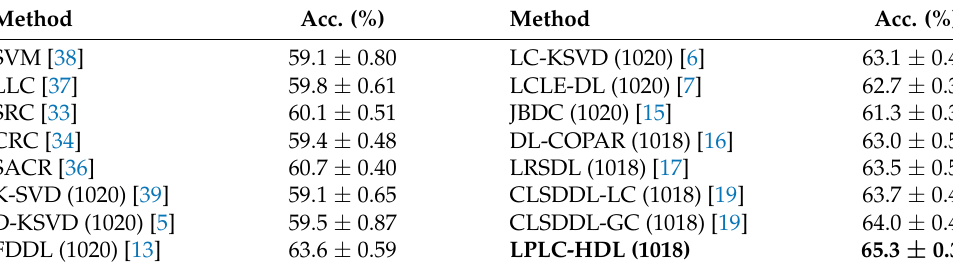
Figure 4. Examples from the Caltech-101 object dataset. Table 5. The classification results (%) on the Caltech101 object